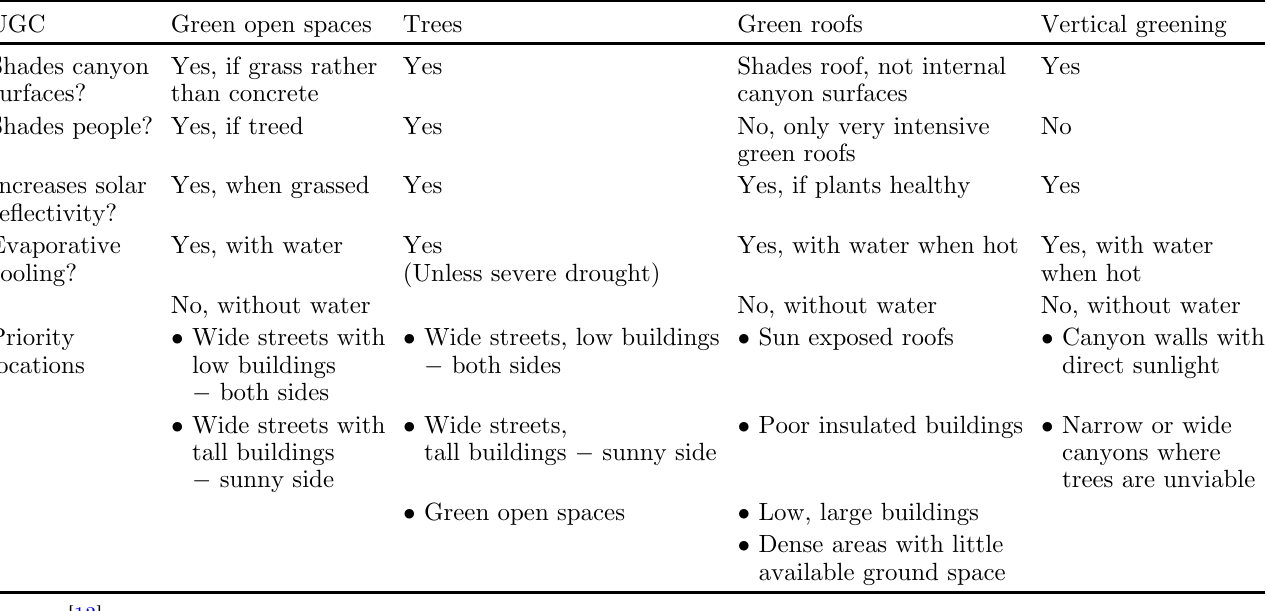
Table 1. Strategic use of different urban green coverage (UGC).